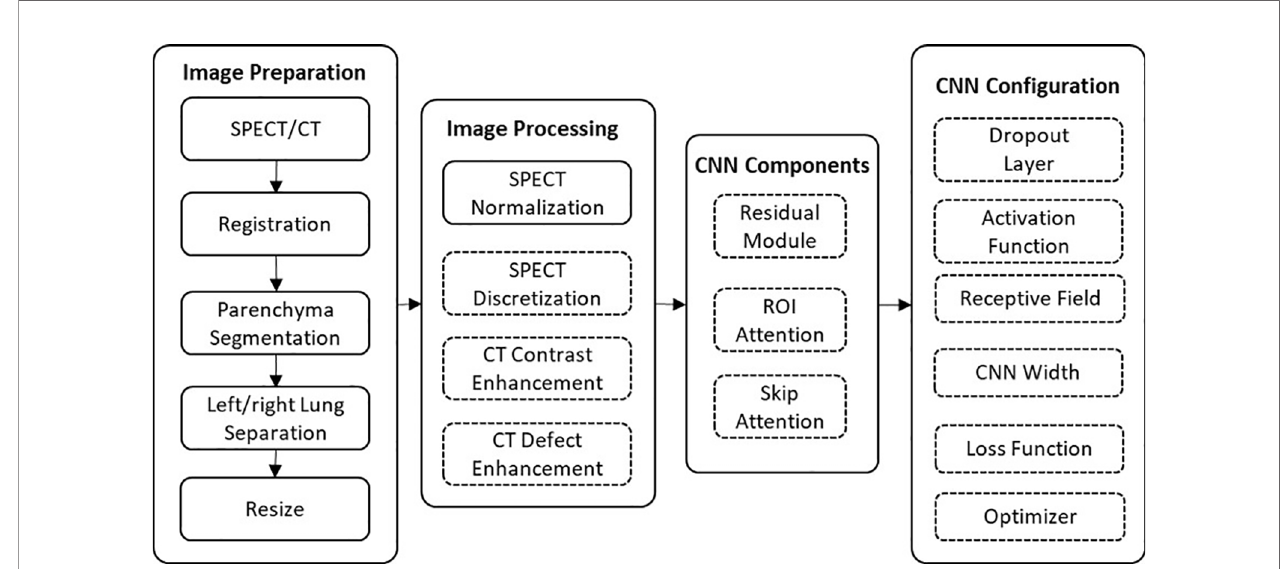
FIGURE 1 | The work fl ow of this framework. The effects of the components in the dashed outlined box were evaluated using ablation